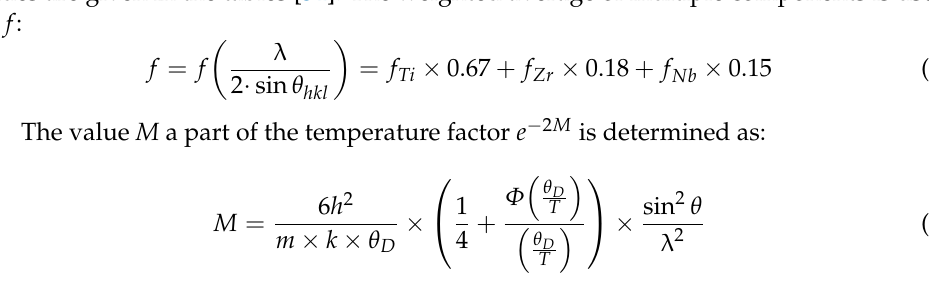
Table 1. Structure and multiplicity factors for different X-ray lines of BCC and HCP crystal structures. Type { hkl } | F | 2 BCC